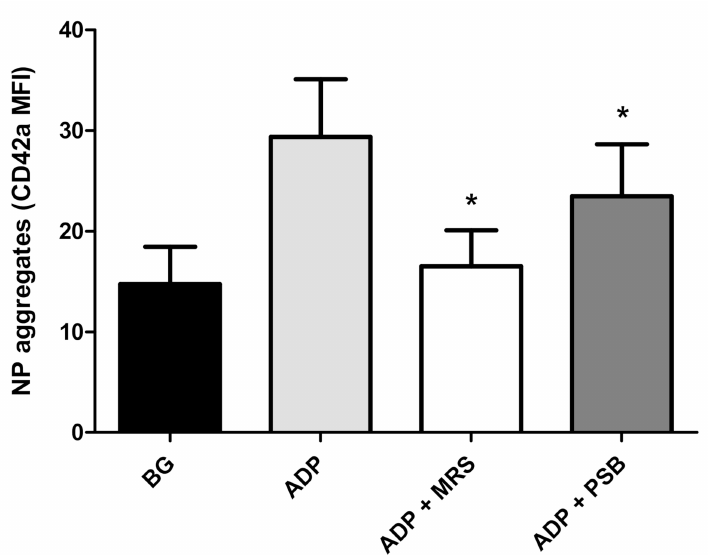
Figure 4. E ff ects of MRS2500 (MRS) and PSB0739 (PSB) both at 10 µ mol · L − 1 on the formation of NP heterotypic aggregates following addition of ADP (100 µ mol · L − 1 ). The results are expressed as the mean fluorescence intensity (MFI) of CD42a-PE emitted by CD16 + / CD45 + neutrophils. * p < 0.05– p < 0.0002 for comparison with the drug-free control system. BG = unstimulated platelets ( n = 5 individual donors with 9–17 experiments in the series).